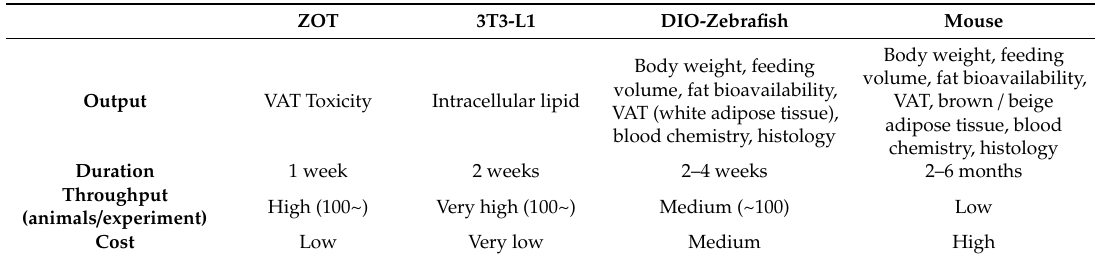
Table 2. Advantages and disadvantages of 3T3-L1 cell-based assay, ZOT, DIO-zebrafish, and mouse experiments. ZOT 3T3-L1 DIO-Zebrafish Mouse Body weight, feeding Body weight, feeding volume, fat volume, fat bioavailability, Output VAT Toxicity Intracellular lipid VAT (white adipose tissue), blood chemistry, histology